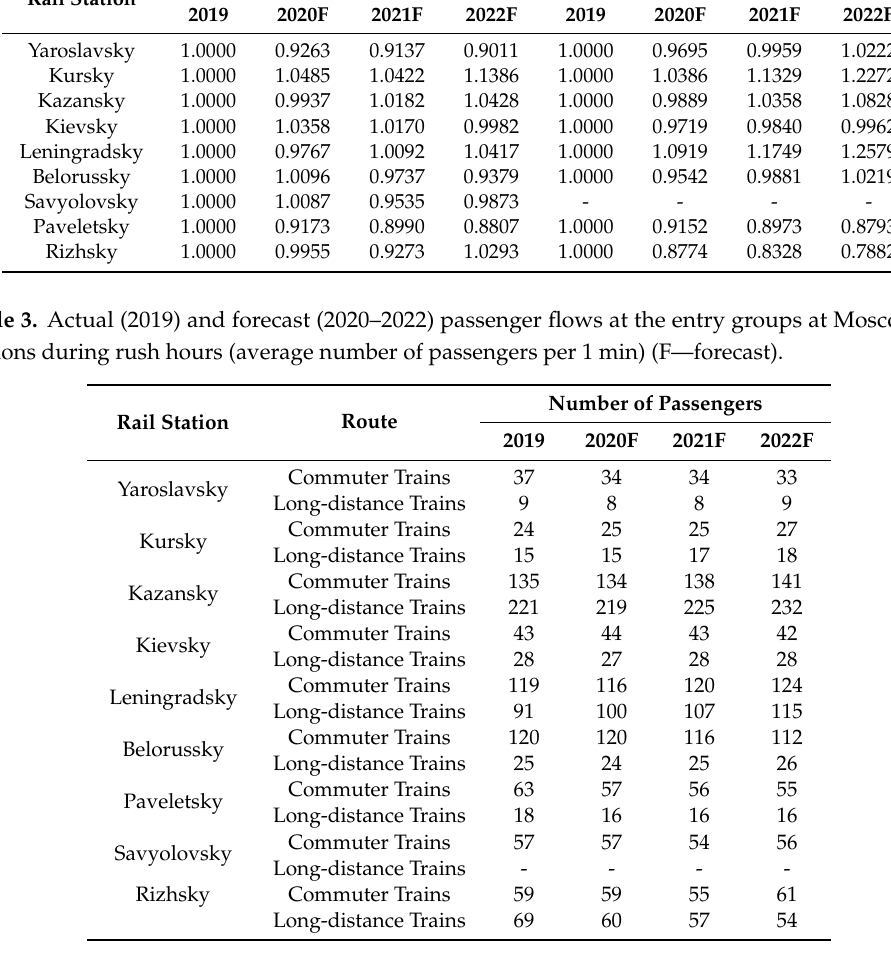
Figure 5. Passenger flow in long-distance trains (LDT) at Moscow rail stations and its forecast, people. Then, base indexes of annual growth were calculated based on the data of 2019 (Table 2). Table 2. Base indexes of annual growth of the passenger flow at rail stations (F—forecast). Rail Station